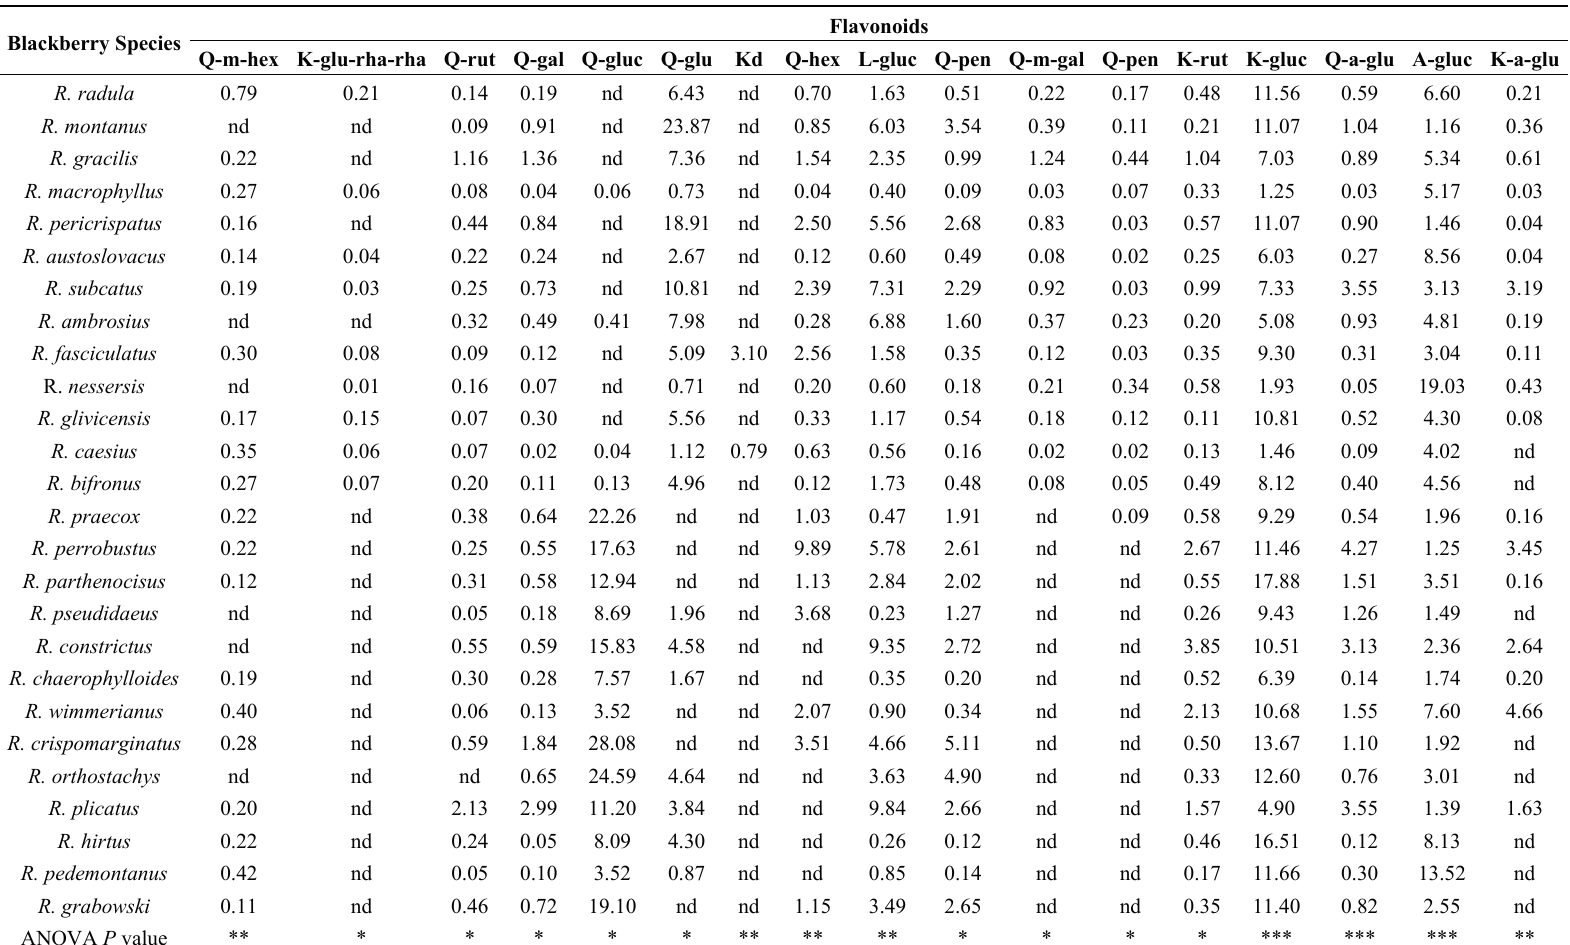
Table 3. Individual quantities (mean † , mg/g dm) of each flavonoids in different leaves of wild Rubus L. species. Blackberry